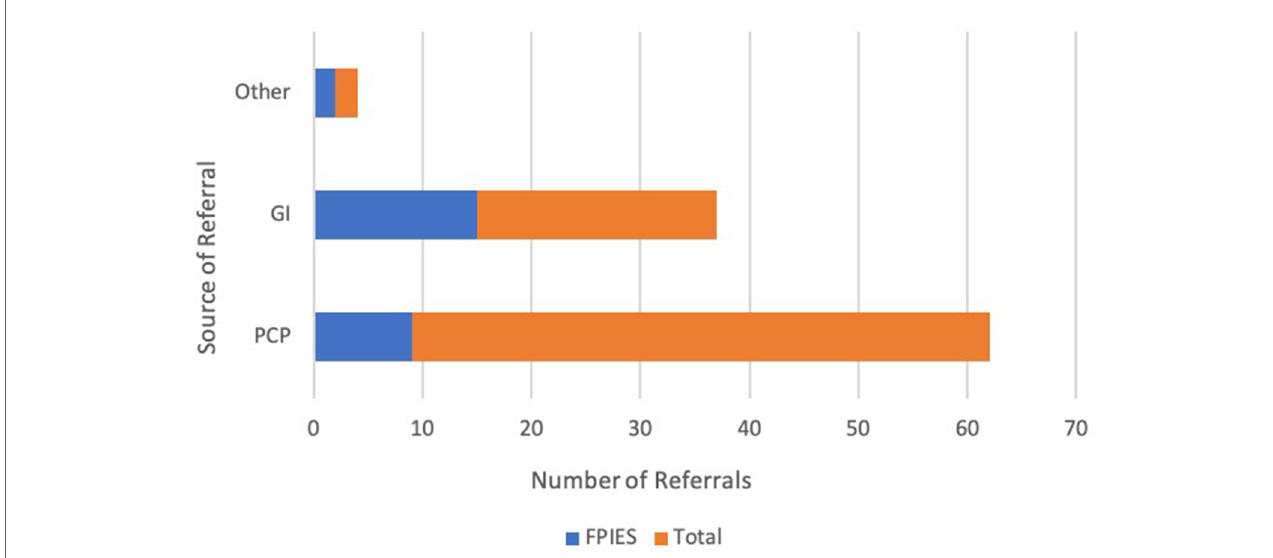
FIGURE 1 Number of total referrals for evaluation in whom FPIES was diagnosed and number of those referrals speci fi cally made for concern of FPIES from each